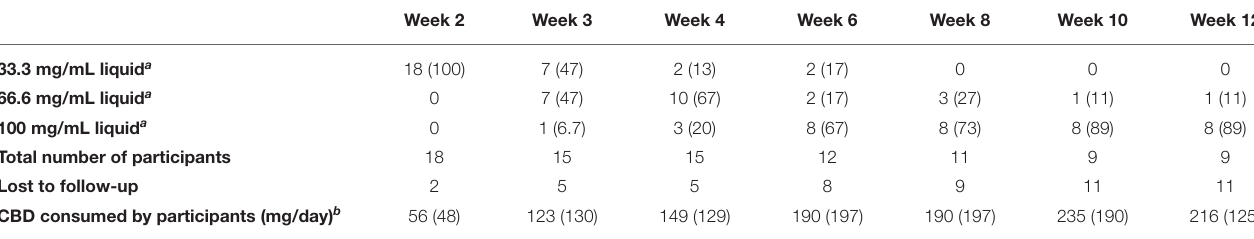
TABLE 3 | Change in CBD consumption during follow-up.